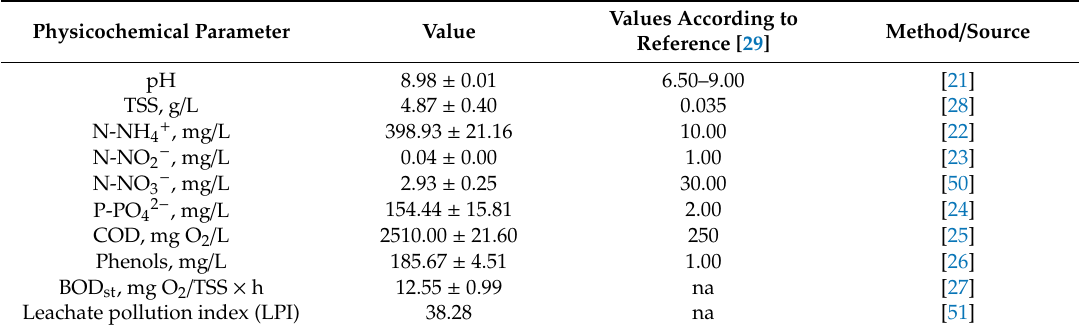
Table 2. Selected physicochemical parameters of the Kalina pond